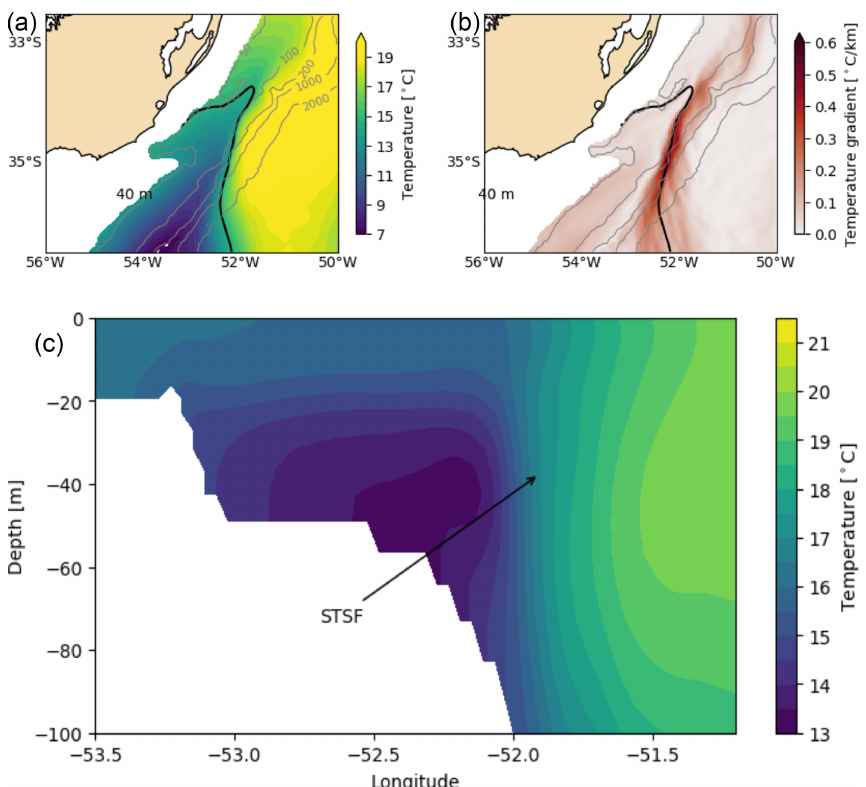
Figure 6. Graphical outputs of the LLC2160 focused on the Subtropical Shelf Front. (a) Variations of temperature in the zone of the front. (b) Temperature gradient; the front is recognized as the zone of maximum gradient (darker colors). (c) Vertical transect at 35 ◦ S showing the location of the Subtropical Shelf Front (STSF) as the gradient of the Subantarctic Shelf Water (deep blue) and the Subtropical Shelf Water (light